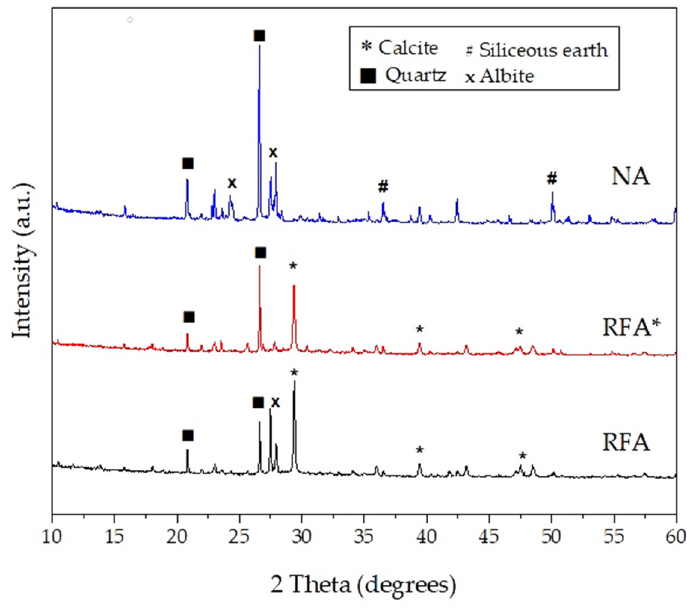
Figure 3. Diffraction patterns for the aggregates.